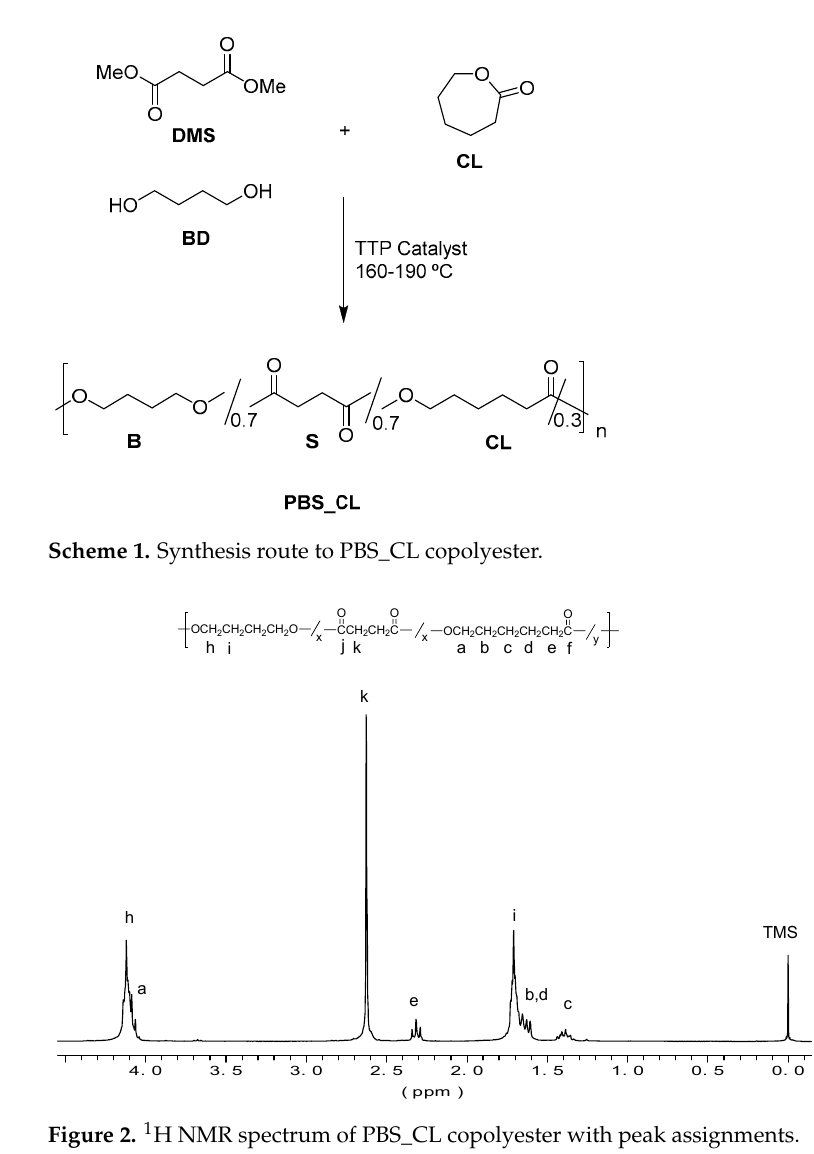
Figure 2. 1 H NMR spectrum of PBS_CL copolyester with peak assignments. It was thermally stable up to 250–300 °C as observed by TGA analysis (Figure 3).